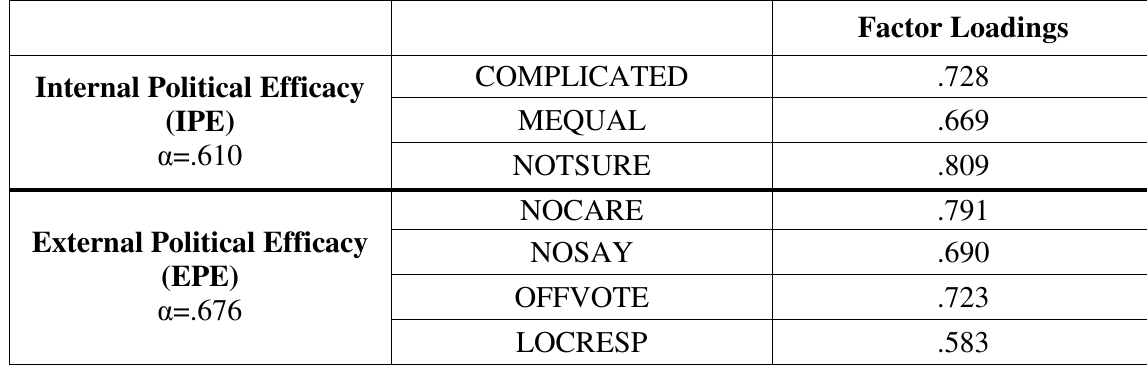
Table 2: Rotated Factor Loadings and Alpha Scores for IPE and